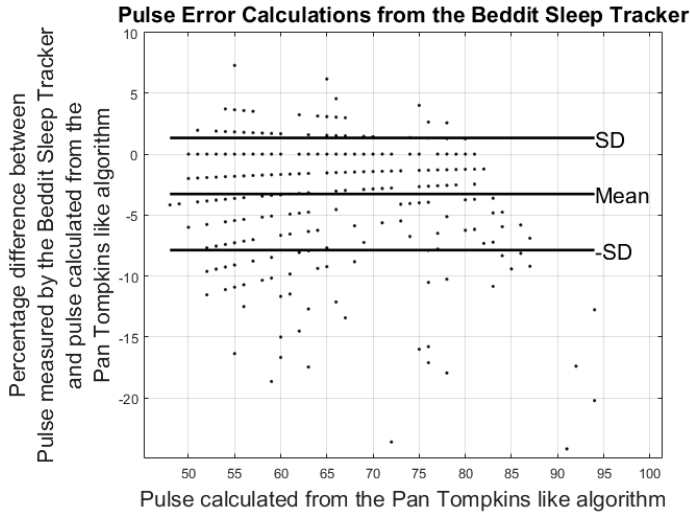
Figure 8. Results from the heart rate study: the plot shows differences in the average pulse calculated from the Beddit sleep tracker and the Pan Tompkins-like algorithm.